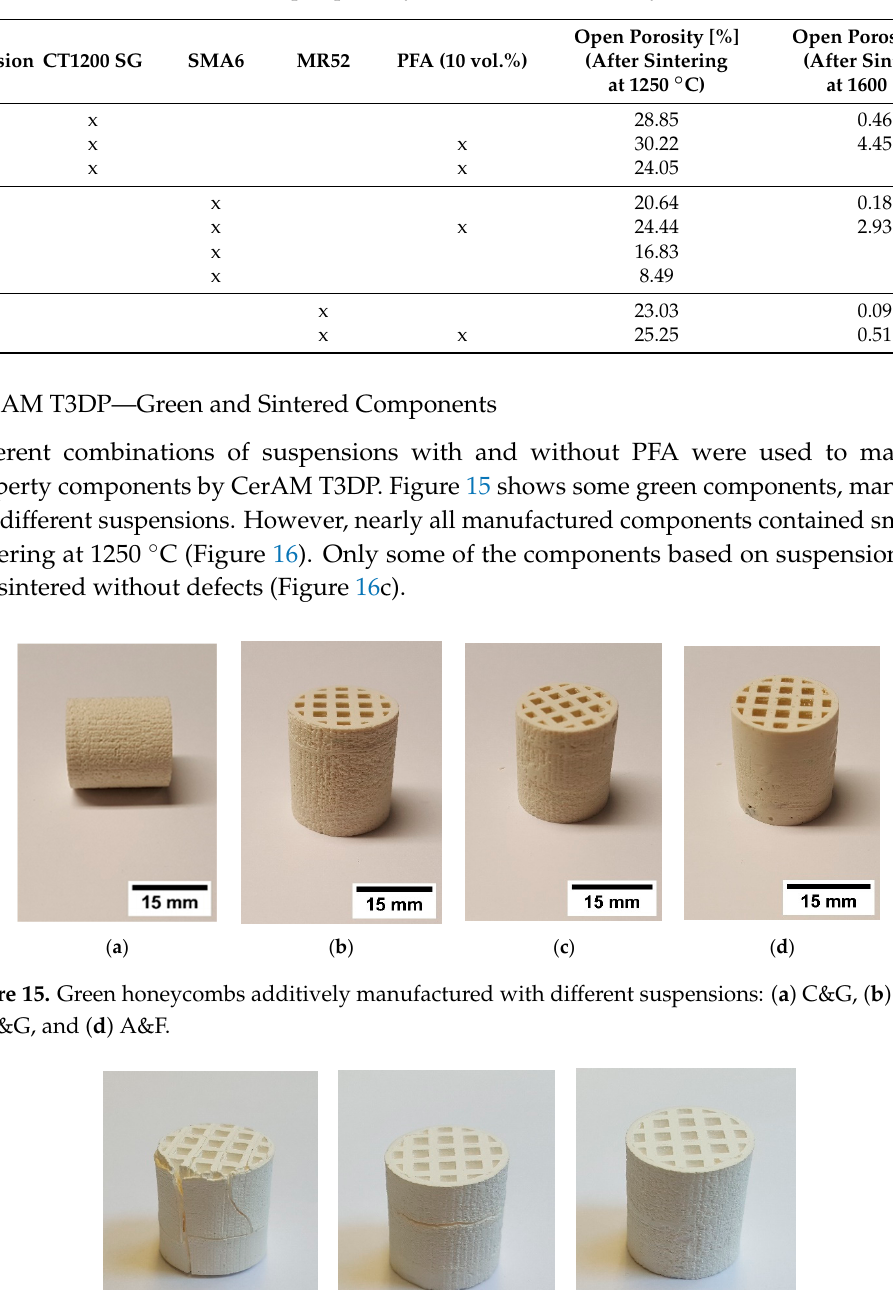
Table 3. Calculated open porosity as a result of the density measurements.